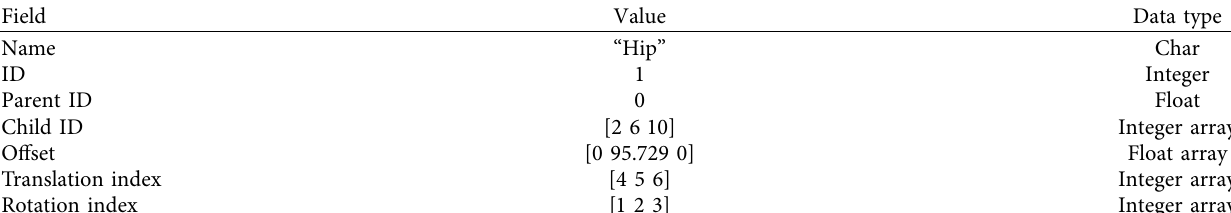
Table 1: A structure example of a single